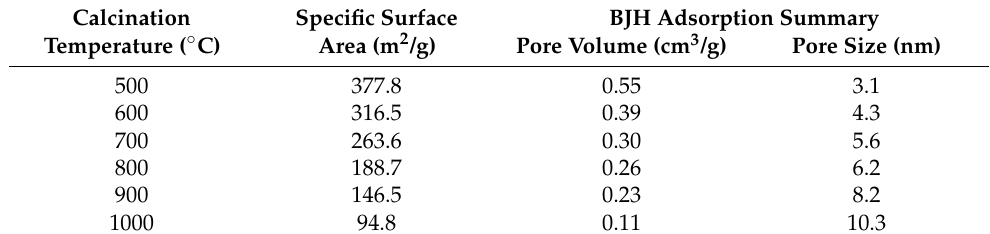
Table 4. Effect of calcination temperatures on physical properties of the nanosized powder.